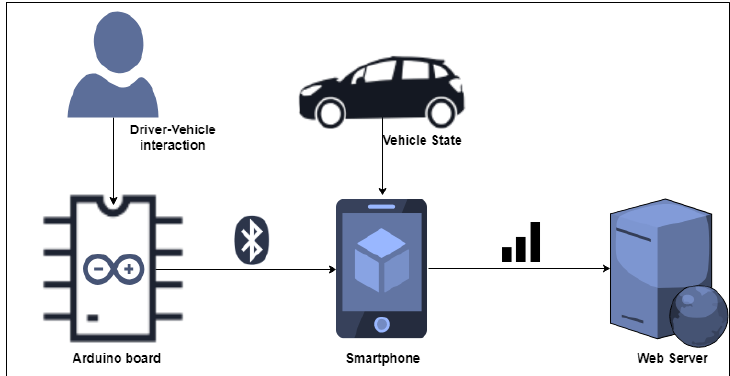
Figure 3. Architecture for data collection based on three components: Arduino, Smartphone, and server.